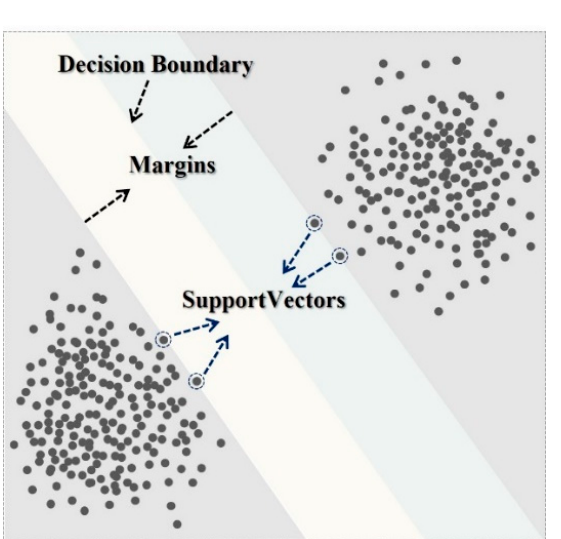
Figure 4. Conceptual diagram of the SVR.